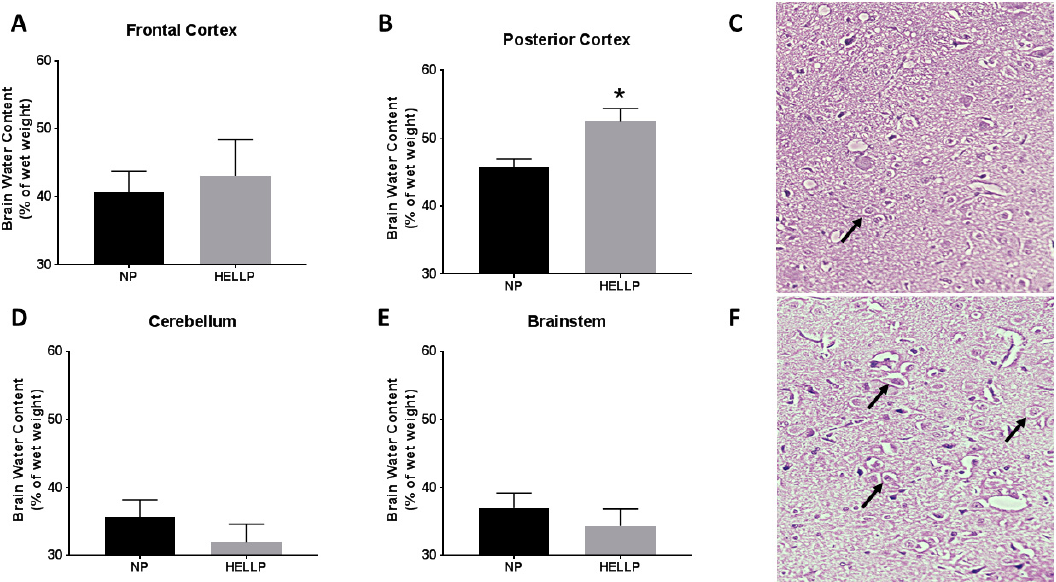
Figure 4. Brains were sectioned into frontal cortex, posterior cortex, cerebellum, and brainstem, and brain water content was measured. There was not a statistically significant difference in water content in the frontal cortex ( A ), however rats with HELLP syndrome had significantly more water content in the posterior cortex ( B ). There were no statistically significant changes in the cerebellum ( D ) and the brainstem ( E ). Light microscopy of the posterior cortex from NP control rats ( C ), and HELLP ( F ) rats with evidence of mild cerebral edema, leukocyte infiltration, and perivascular edema, as indicated by the black arrows—20 × Magnification. Data are represented as mean ± SEM; * denotes p < 0.05; n = 3–4/group.